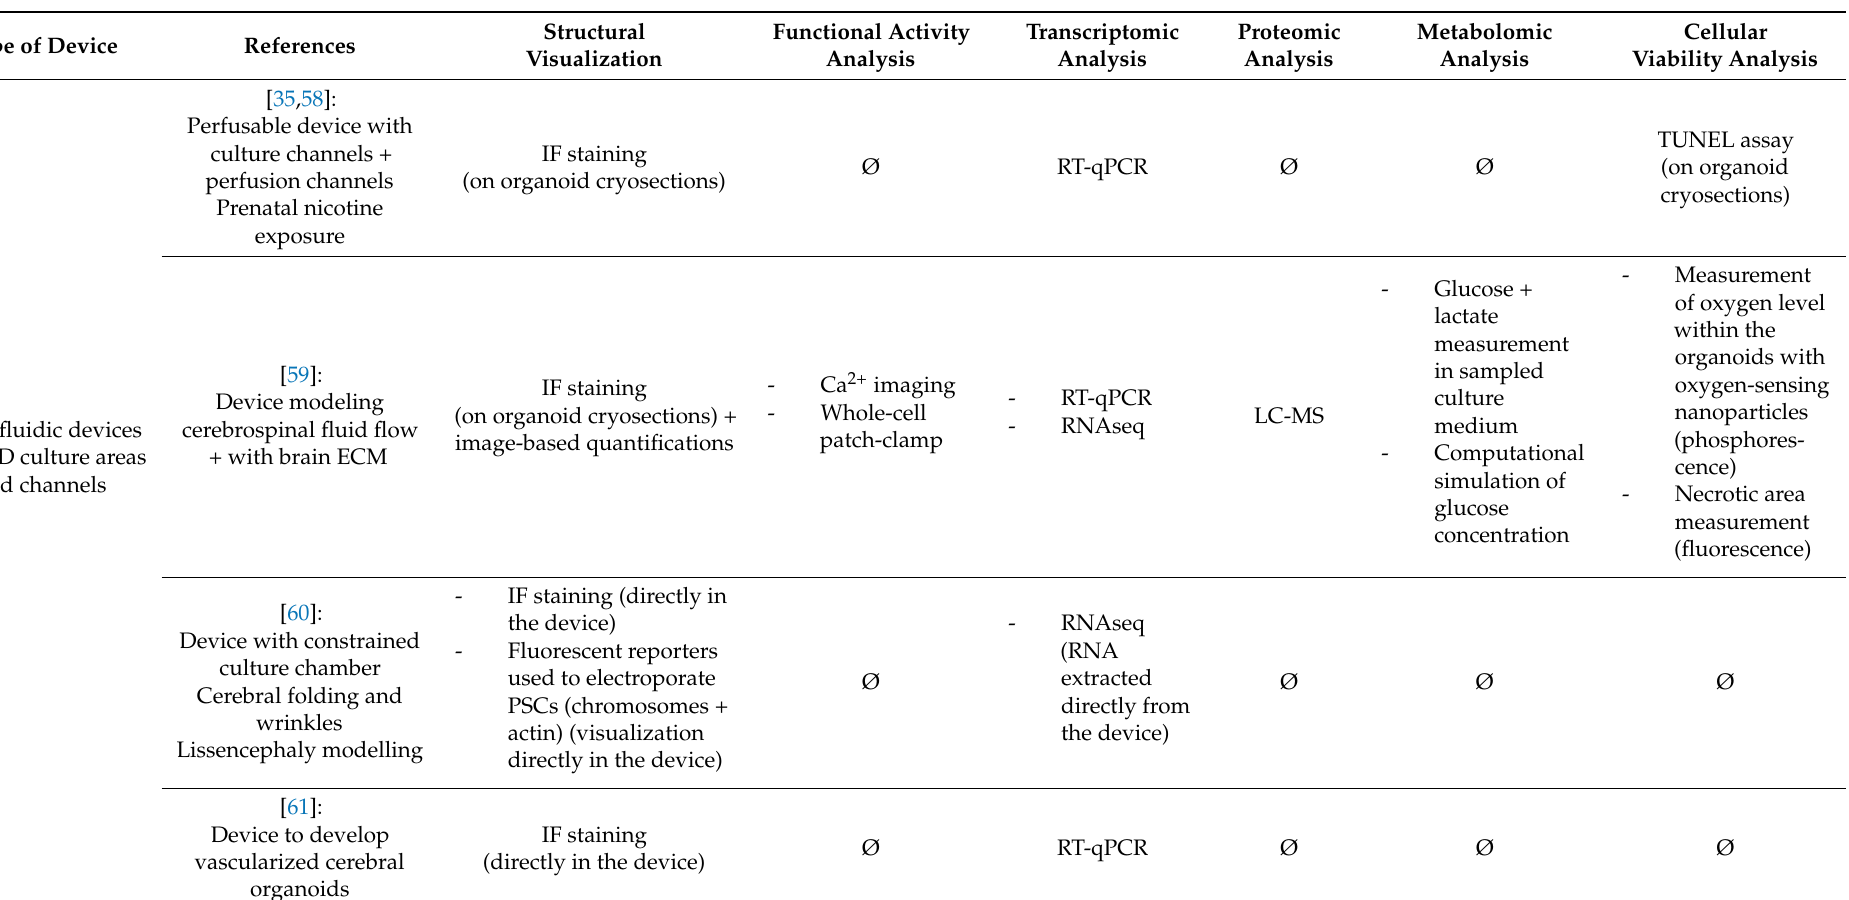
Table 3. Readouts and data collection methods of current brain organoids-on-chip technologies. Abbreviations: IF: immunofluorescence staining, RT-qPCR: